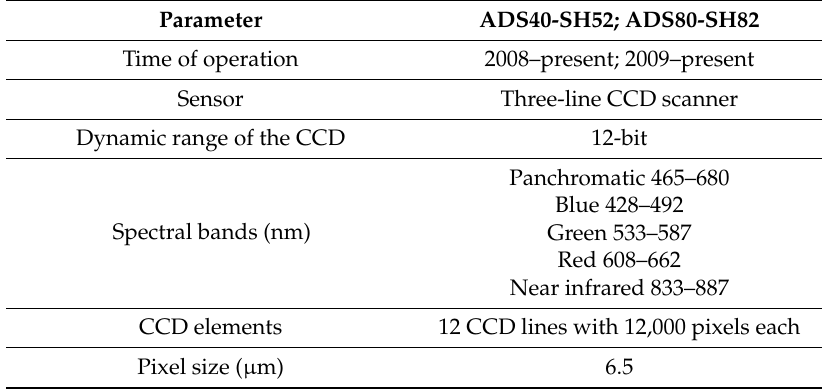
Table 1. Technical specifications of the two ADS sensors, as used by Swisstopo for the countrywide image acquisition.